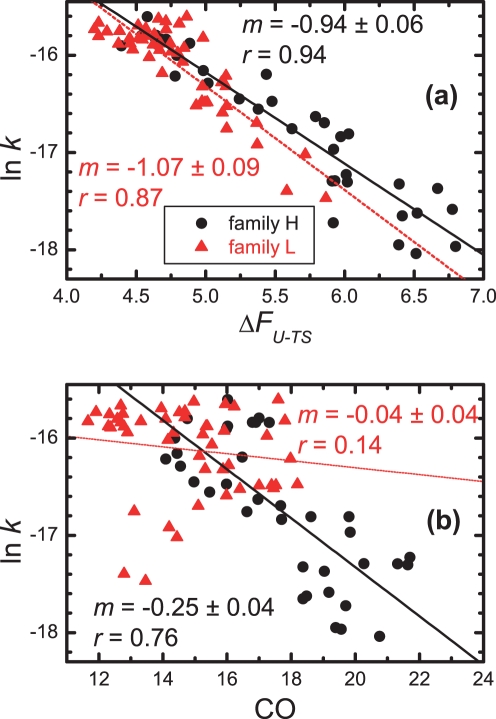
Dependence of the logarithm of the folding rate k on (a) the activation energy of folding, and (b) the contact order of the corresponding native structure, for the two families of circular permutants considered in this work.We also report the slopes (m) and the absolute values of the correlation coefficients (r) for the corresponding linear fits.